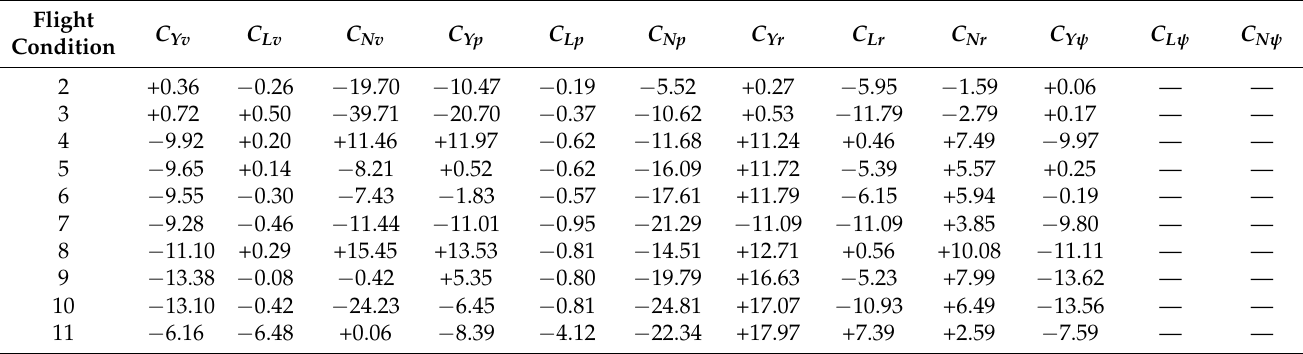
Table 30. Relative accuracy of landing lateral stability derivatives (percentage discrepancy % between extrapolation and CFD–RANS).